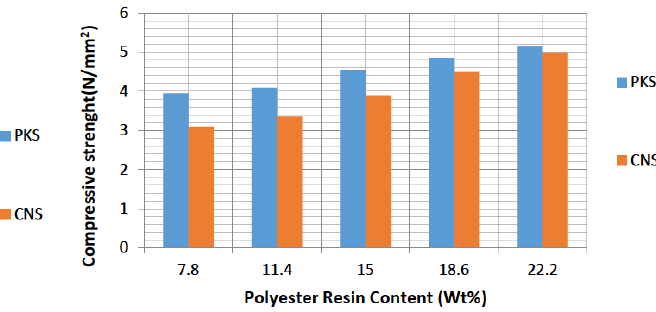
Figure 15: Water absorption characteristics of PKS & CNS/% weight composition for 250 µ m sieve size